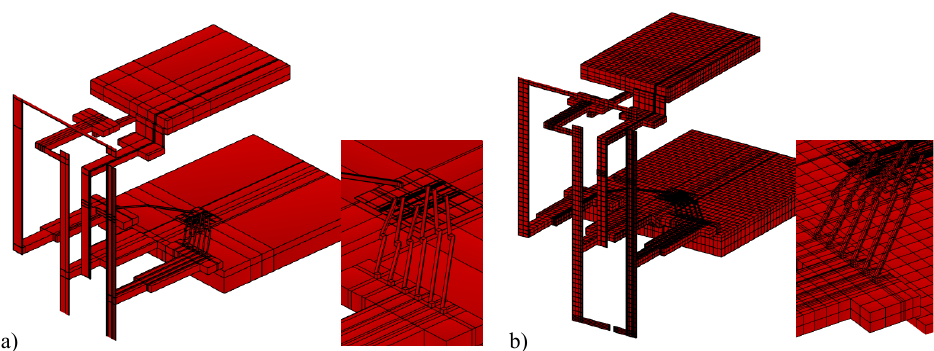
Figure 3. PEEC meshing procedure: ( a ) cutting the 3-D modeling domain, and ( b )